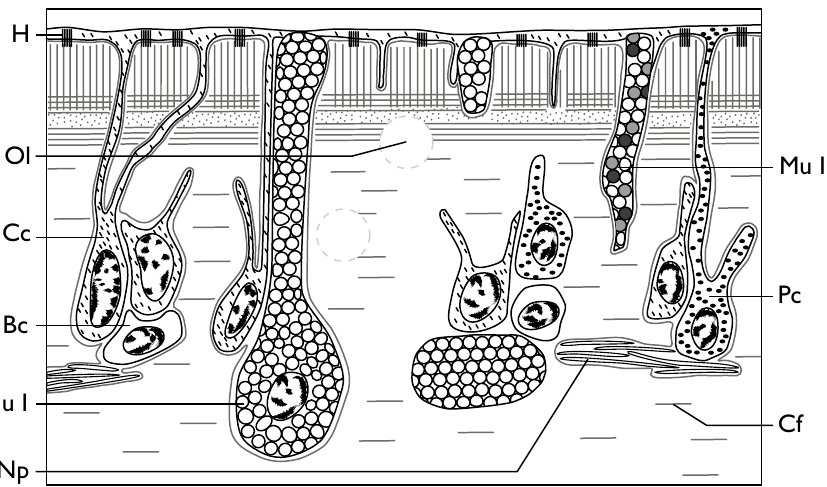
Figure 7. Schematic view of the fine structure of the Holothuria scabra dorsal integument. This schematic representation is based on TEM observations. Legend: Bs basal cell, Cc covering cell, Cf collagen fiber, H hemidesmosome, Mu I Type I mucocyte, Mu II Type II mucocyte, Np nerve process, Ol ossicle lacunae, Pc pigment cell.